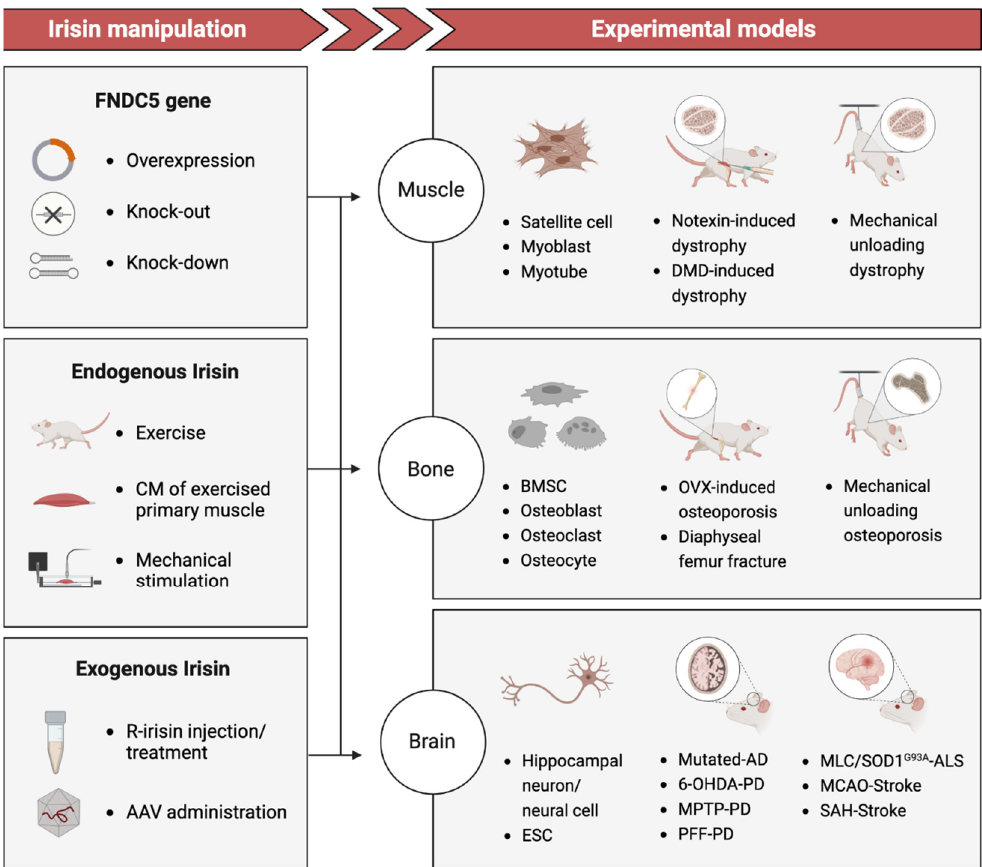
Figure 1. Basic studies: Irisin manipulation via gene regulation/exercise/mechanical stimula- tion/recombinant in experimental models including tissue engineering and animal models. FNDC5: Fibronectin domain-containing protein 5; Gene overexpression includes retinoic acid